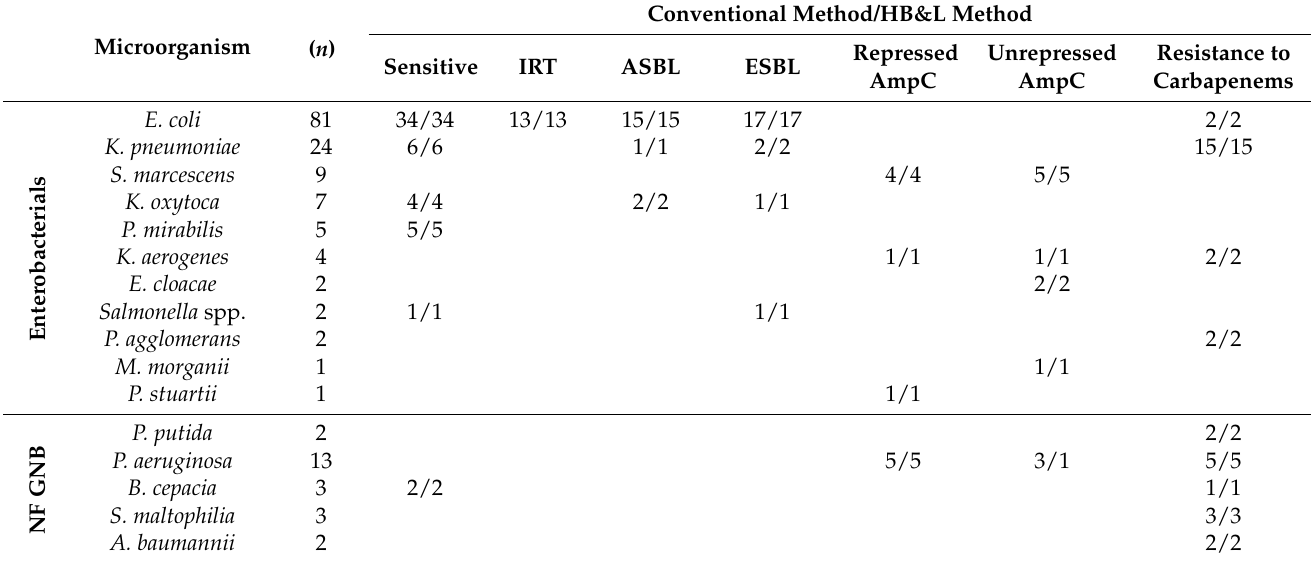
Table 2. Distribution of resistance profiles and concordance between the conventional identification method and antibiogram and the method proposed by HB&L.